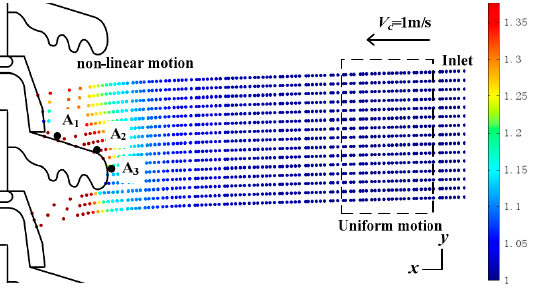
Figure 4. Particle trajectory when moving through the airflow field and the electric field around an insulator.